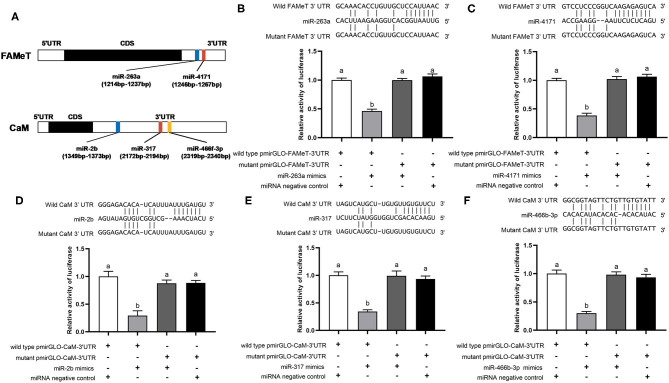
Predicted binding sites of the miRNAs in the 3′ UTRs of their target (A) and validation of interactions between the selected pairs of miRNAs and their targets, including miR-263a/FAMeT (B), miR-4171/FAMeT (C), miR-2b/CaM (D), miR-317/CaM (E) and miR-466b-3p/CaM (F), via dual luciferase reporter assay. Above the histograms, nucleotide sequences of miRNAs and targets wild-type and mutant 3′ UTR regions are shown. The histograms present relative luciferase activity in HEK293T cells cotransfected with miRNA mimics or miRNA negative control, and pmirGLO vector containing wild-type or mutant 3′ UTR regions of miRNA targets. The relative luciferase activity was calculated by normalizing firefly luciferase activity to Renilla luciferase activity. Different letters on the bars indicate significant differences based on one-way ANOVA followed by Tukey's HSD multiple comparison test (p < 0.05).